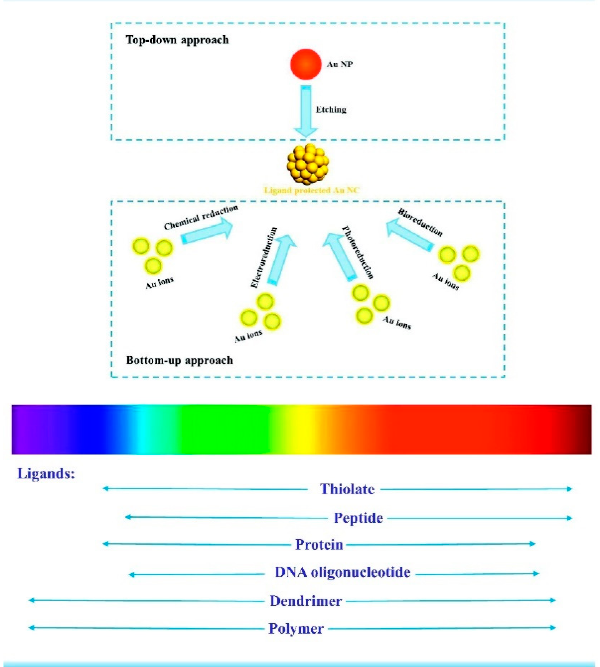
Figure 1. Schematic illustration of synthetic strategies of luminescent AuNCs and effect of ligands on their photoluminescence. Reprinted with permission from Ref. [14]. Copyright (2017) Elsevier.